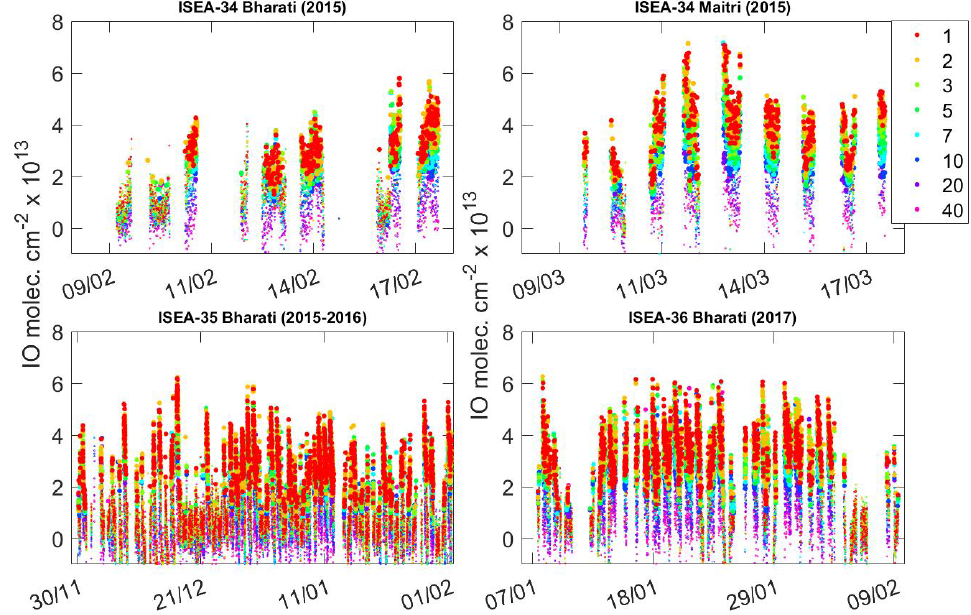
Figure 5. IO DSCDs observed during the four campaigns are shown. The smaller circles represent values below the 2 σ detection limit of the instrument, while the bigger circles are values above the 2 σ detection limit. The data are color-coded according to elevation